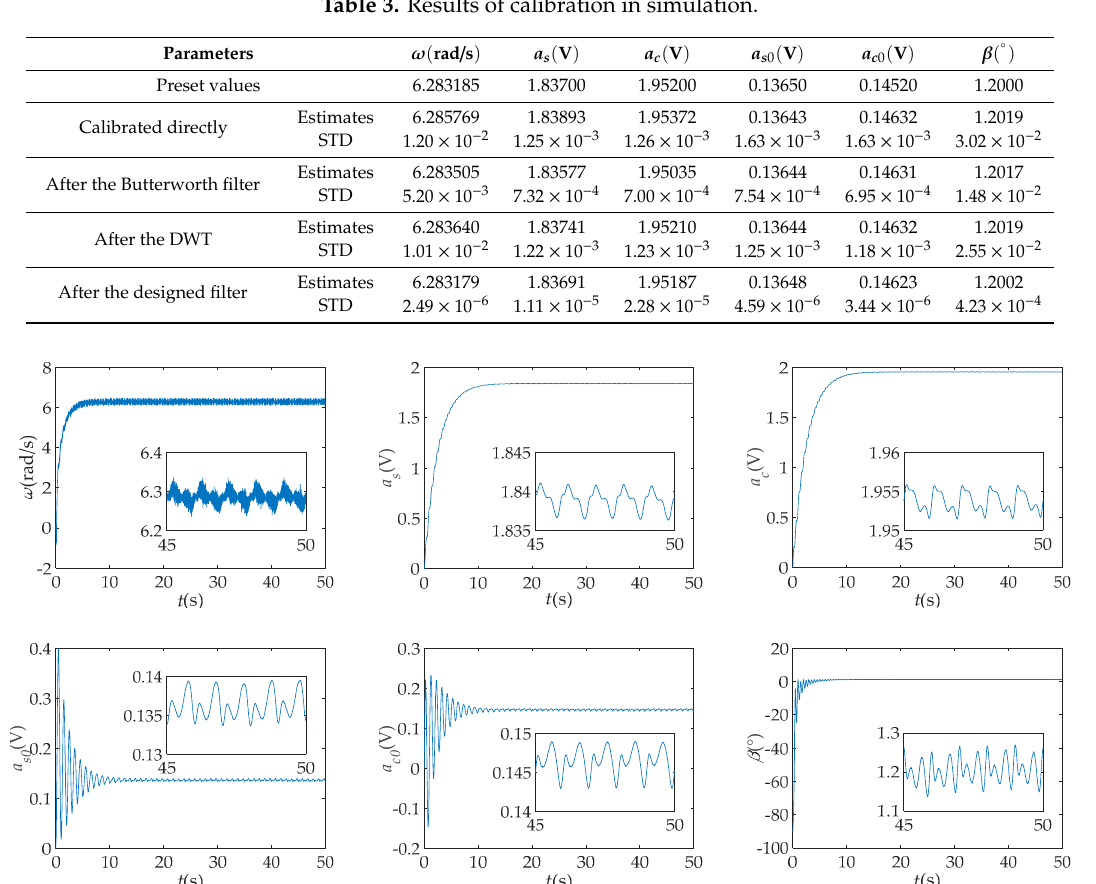
Table 3. Results of calibration in simulation.